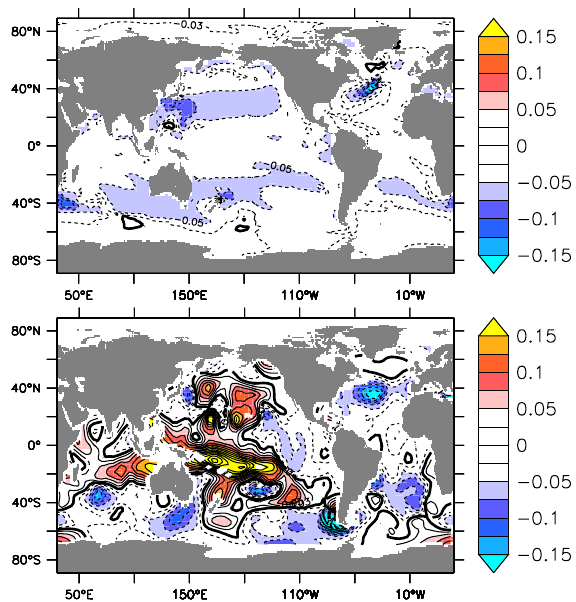
Fig. 9. Density changes at 300dbar in kgm − 3 for the period 1960 to 2010 (a) for the standard model run (Fig. 4a) and (b) the data (Fig.